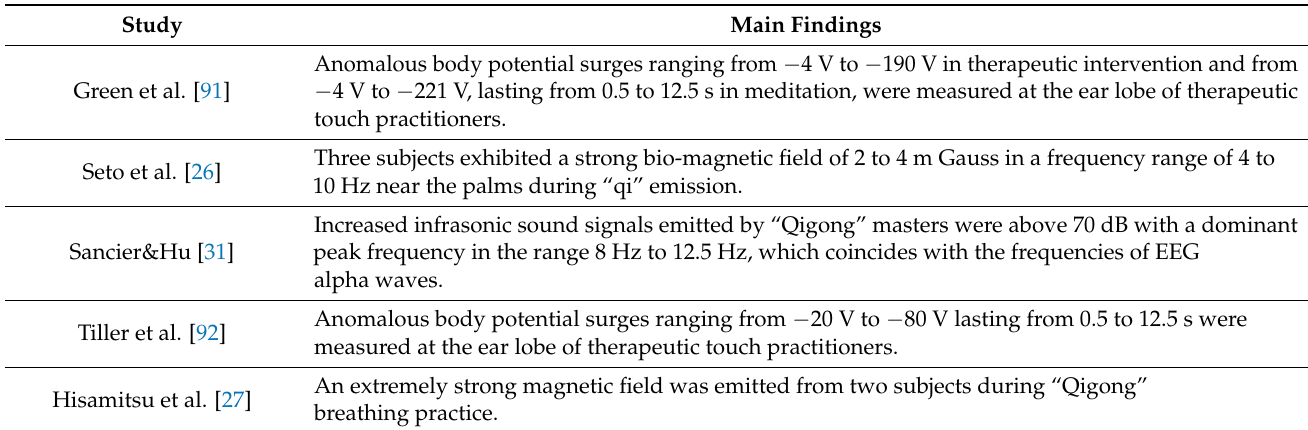
Table 1. Research exploring the effects of non-contact biofield practices assessed with physical signal detectors. Main